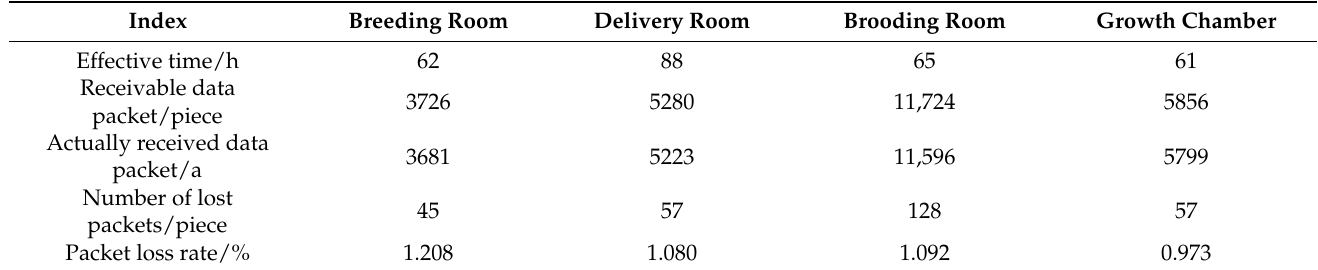
Table 10. Gateway packet loss